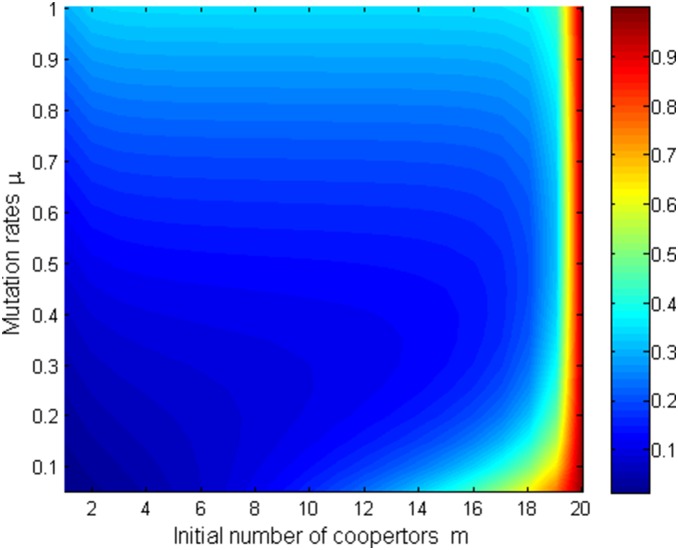
µ, m vs ρm with β = 0.5, b = 1.2.